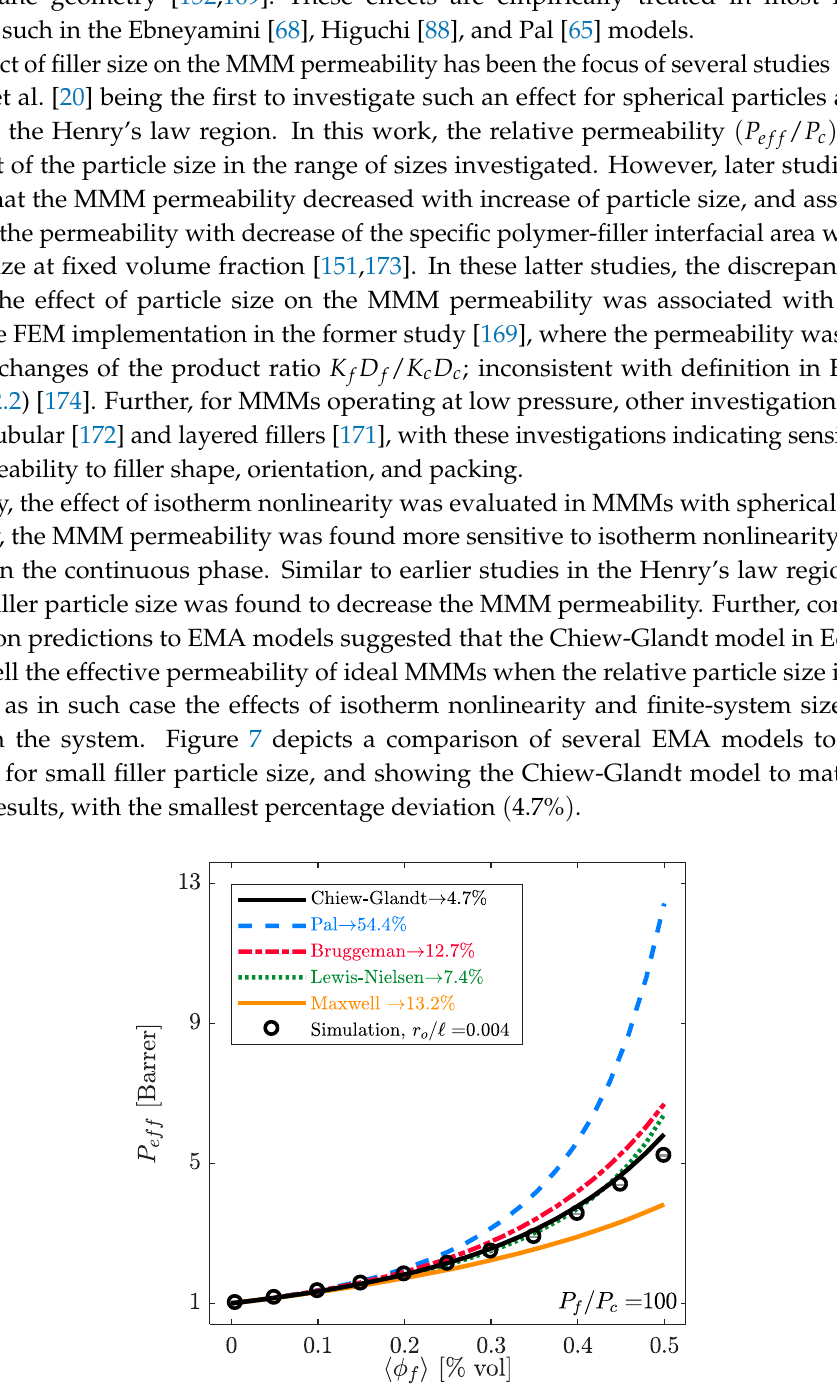
Figure 7. Comparison of the permeability profiles based on various effective medium approach (EMA) models to simulation results for r o / (cid:96) = 0.004 from [151], with α fc = P f / P c = 100.